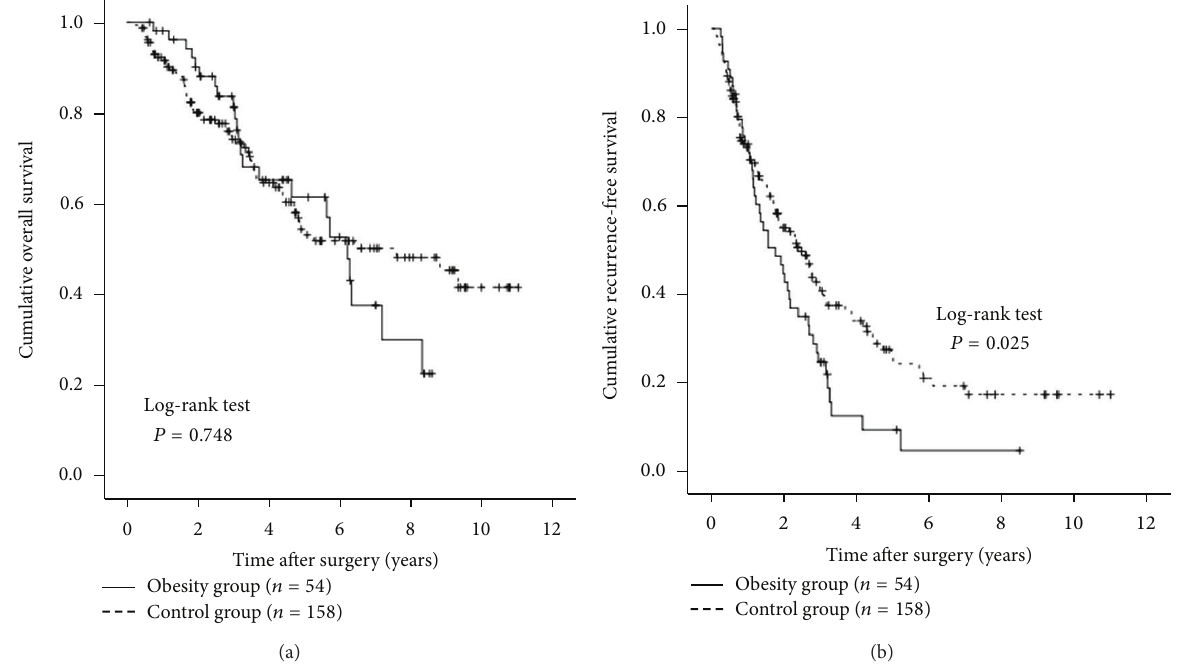
Figure 6: Subgroup analyses in patients with the Child-Pugh grade A ( 𝑛 = 212 ). There were 54 patients with the Child-Pugh grade A in the obesity group and 158 in the control group. In terms of OS (a), there was no significant difference between the two groups ( 𝑃 = 0.748 ). RFS rates were significantly higher in the control group than in the obesity group (b) ( 𝑃 = 0.025 ).